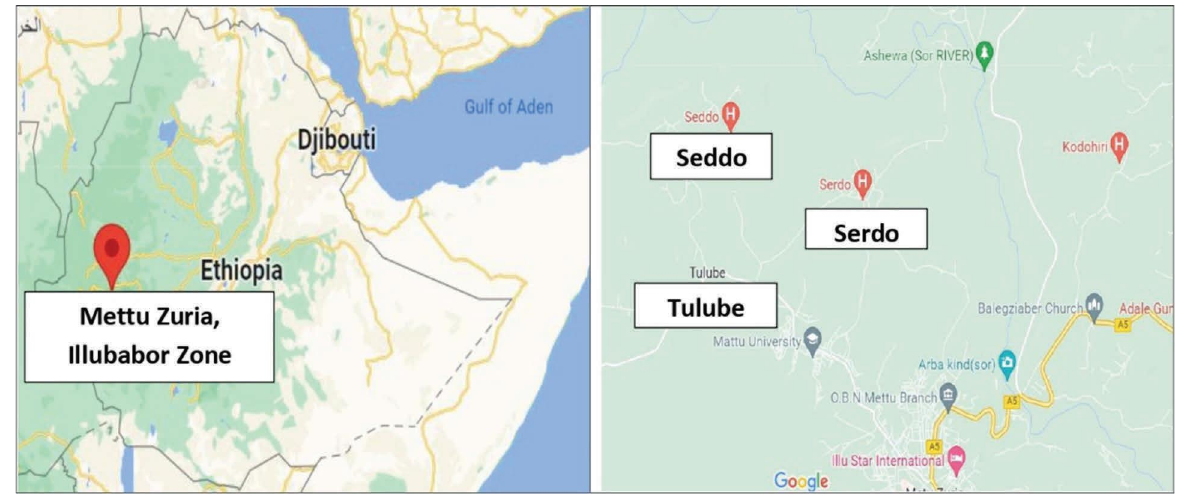
Figure 1: Representation of the study